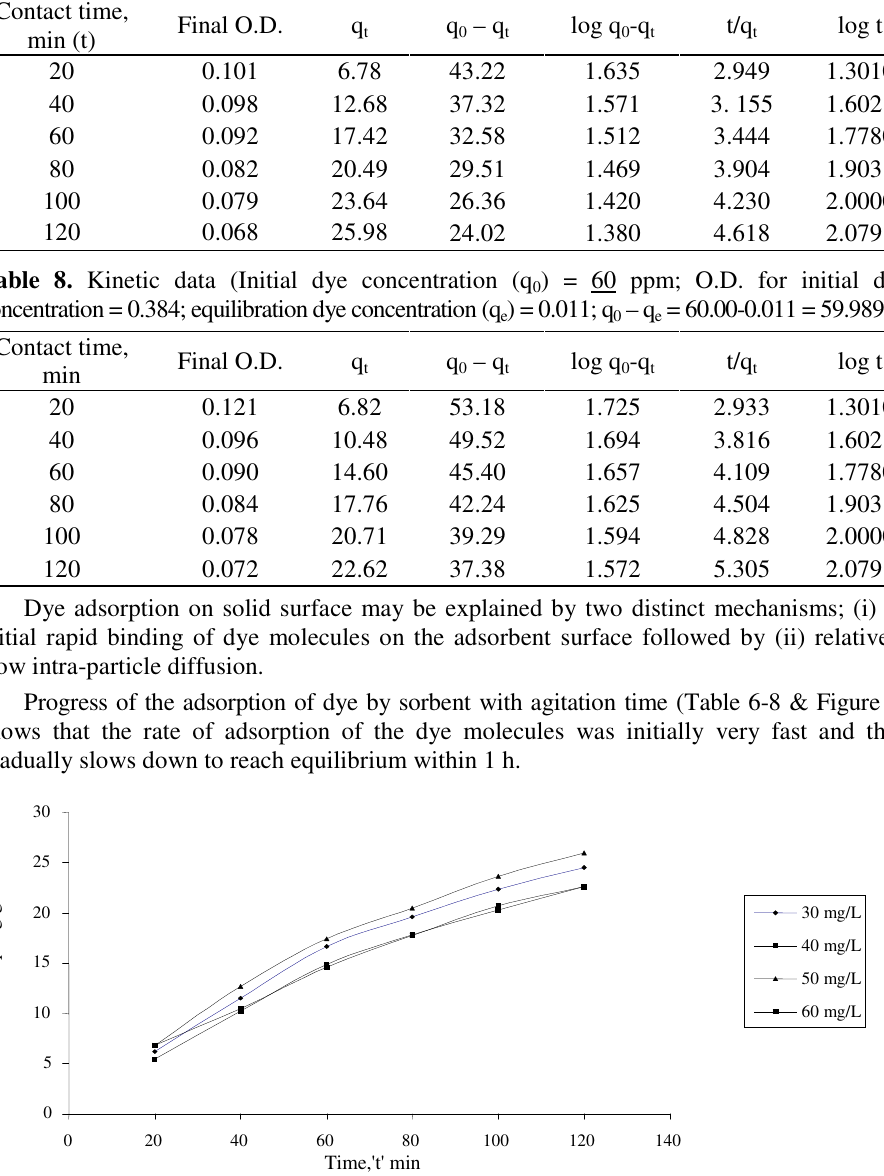
Table 7. Kinetic data (Initial dye concentration (q concentration = 0.312; equilibration dye concentration (q Contact time,